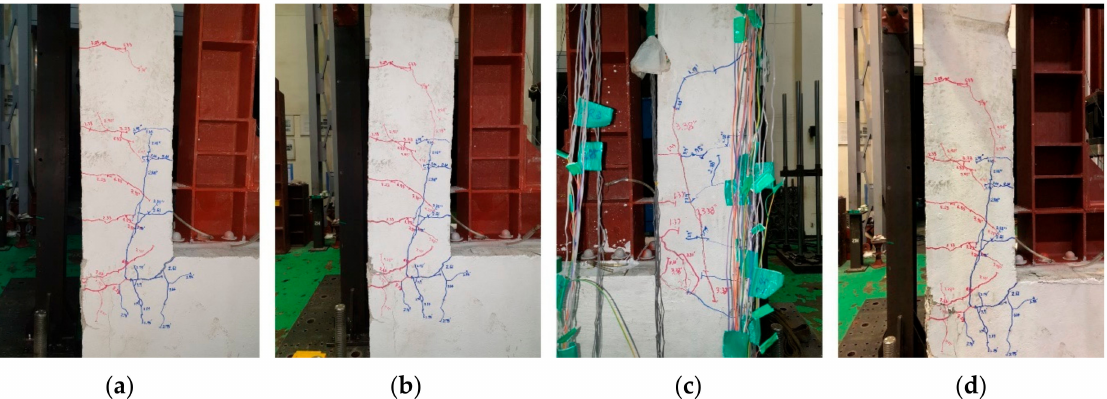
Figure 18. Cracks and ultimate state of test frame retrofitted with NBSD-WSCS (PD-NBSD-WSCS) (400 cm/s 2 ): ( a ) flexural and shear cracks at around 2.88 s (75.1 mm), ( b ) flexural and shear cracks at around 3.38 s (85.2 mm), ( c ) flexural and shear cracks at around 3.7 s (85.6 mm), and ( d ) patterns at the final stage (10